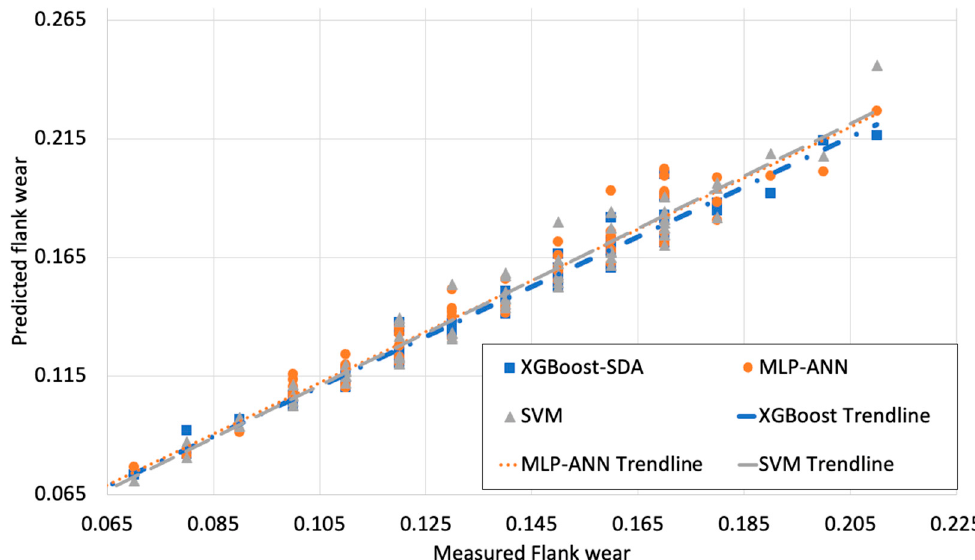
Figure 8. Measured Flank wear values vs. predicted flank wear values of a drilling process.